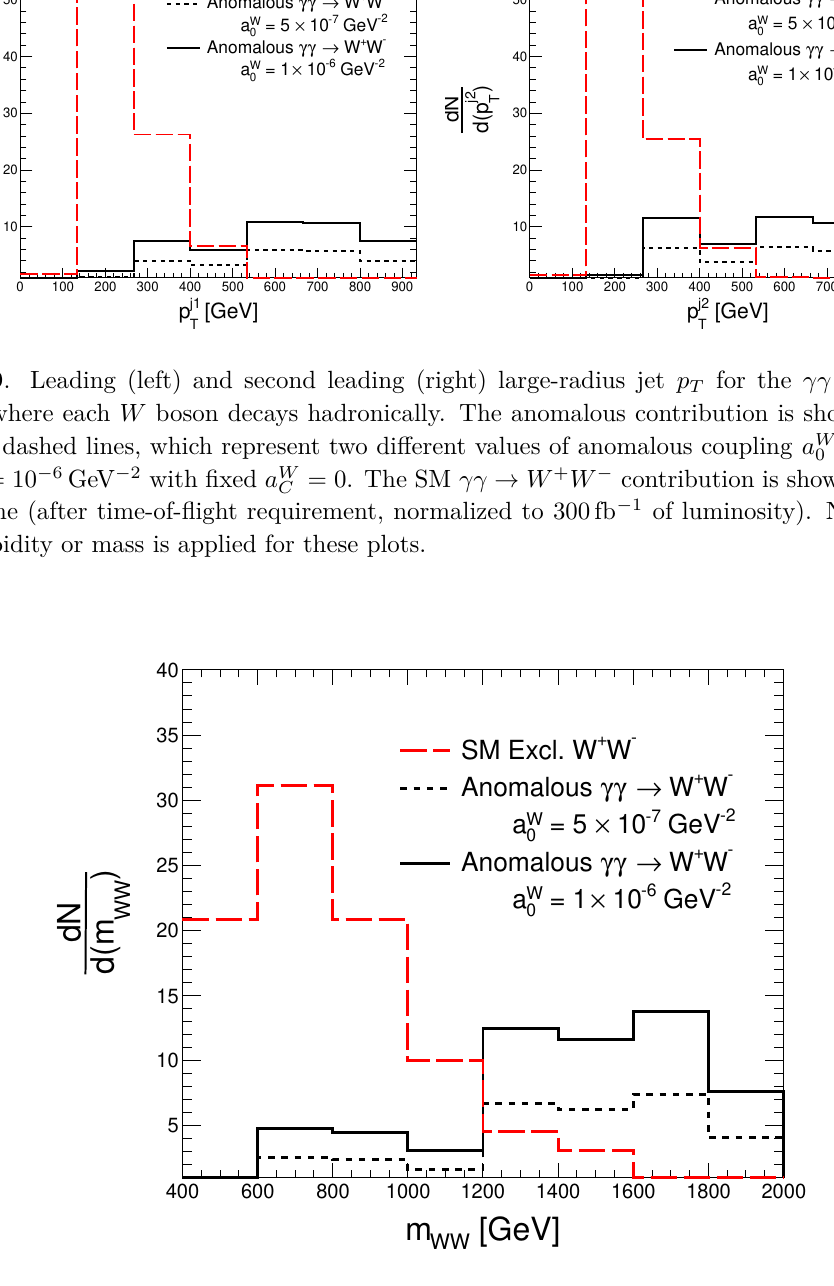
Figure 10 . W + W − invariant mass reconstructed using the fully-hadronic final state. The SM γγ → W + W − contribution is in red dashed line, whereas the anomalous contribution is in black solid and dashed lines, corresponding to different coupling values. The distributions are normalized to an integrated luminosity of 300 fb − 1 . Contributions induced by anomalous couplings are present mostly at higher mass (no form factor